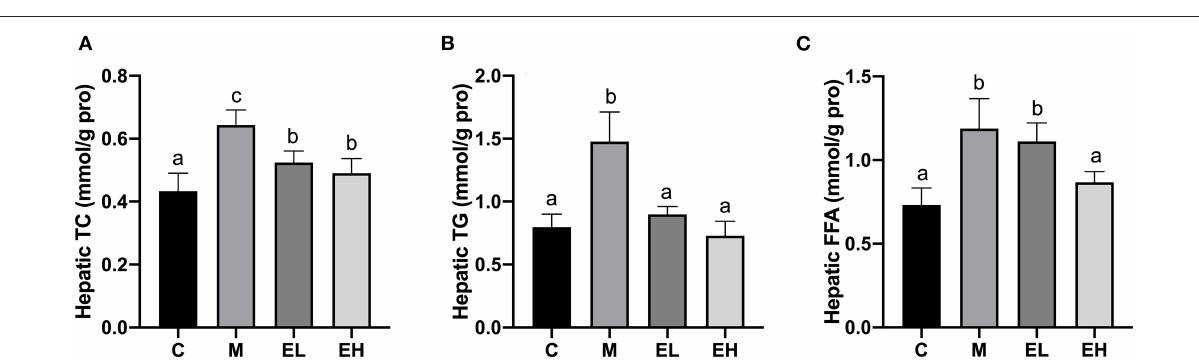
FIGURE 3 | Effect of ellagic acid on hepatic lipid profile in mice. (A) Hepatic TC; (B) Hepatic TG; (C) Hepatic FFA. Values represent the mean ± SD ( n ≥ 6). Labeled means without a common letter difference. p < 0.05 by one-way ANOVA followed by Duncan’s test. C, normal group; M, model group; EL, low dose of ellagic acid group; EH, high dose of ellagic acid